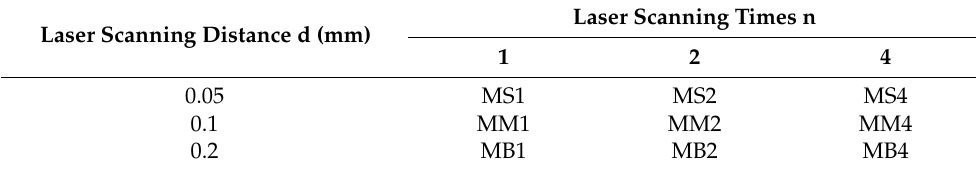
Table 1. Specimens with different laser micro-texturing pretreatment parameters.